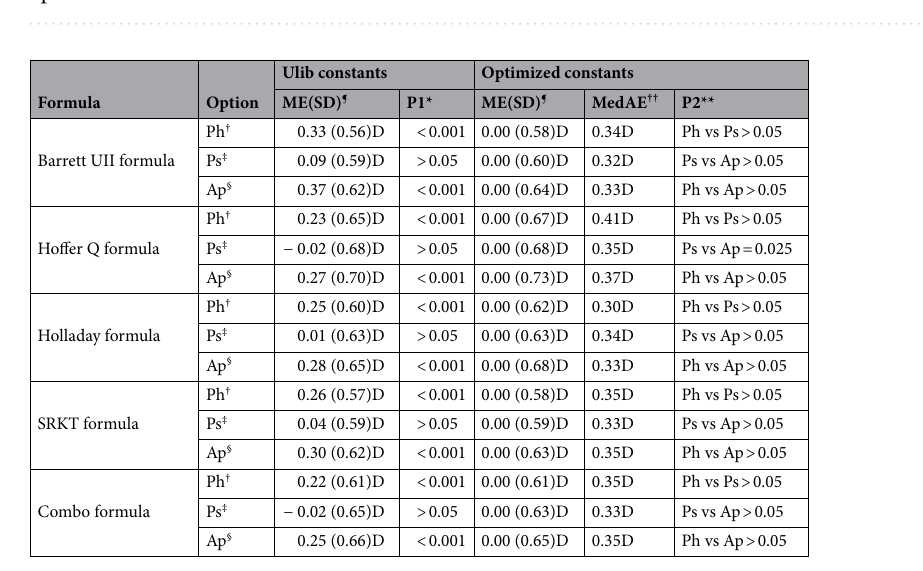
Table 2. Comparison between mean errors of refractive prediction errors with ULIB constants and median absolute errors of refractive prediction errors with optimized constants for each formula. † Preoperative axial length, phakic option; ‡ postoperative axial length, pseudophakic option; § postoperative axial length, aphakic option; ¶ mean error (standard deviation); *p value obtained by one-sample T-test to check whether the value was different from zero; †† median absolute error; **p value obtained from pair-wise comparison of absolute errors by Friedman’s test with Bonferroni